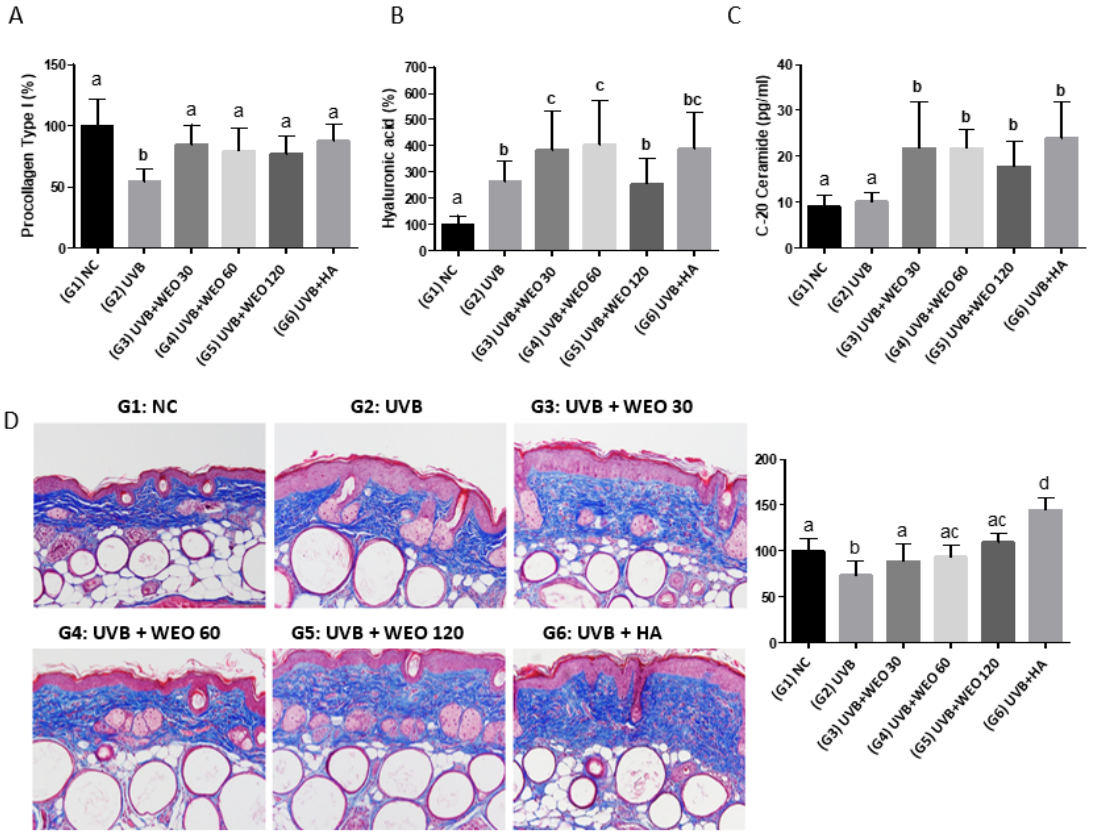
Figure 2. Effect of WEO on skin tissue components at 12 weeks. ( A ) Procollagen type I measurement by ELISA. ( B ) Hyaluronic acid measurement by ELISA. ( C ) Ceramide measurement by LC/MS/MS. ( D ) Collagen measurement by Masson’s trichrome stain. Values with different letters are significantly different by ANOVA followed by the Newman–Keuls multiple range test ( p < 0.05). NC: normal control, UVB: Ultraviolet, WEO: wheat extract oil, HA: Hyaluronic